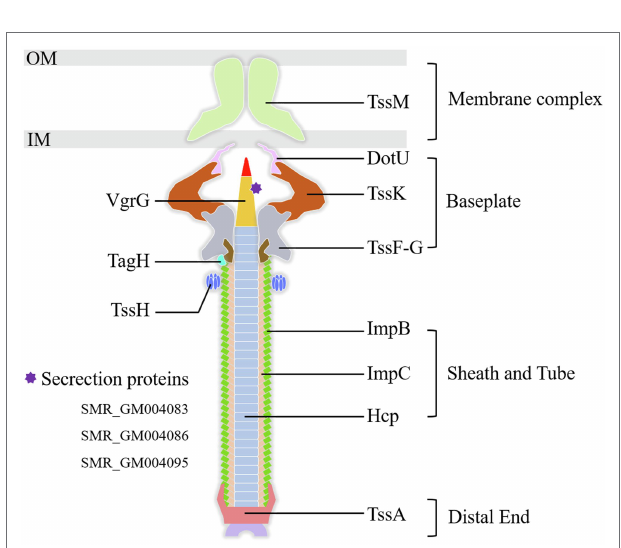
FIGURE 6 | The components of the T6SS detected in the present study. All the labeled genes are significantly downregulated in the spontaneous non- pigmented mutant SCQ1-3M. The DEGs of T6SS related secretion proteins in the present study were listed at lower-left. OM, outer membrane; IM, inner